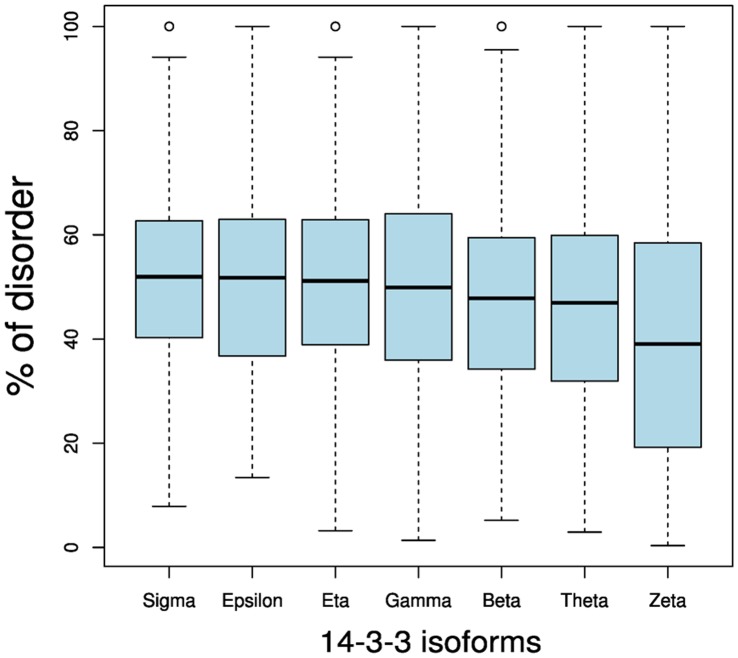
Box plot representation of the disorder content in partners of each 14-3-3 family member.Fisher exact test comparisons between isoforms are summarized in the Table S3.